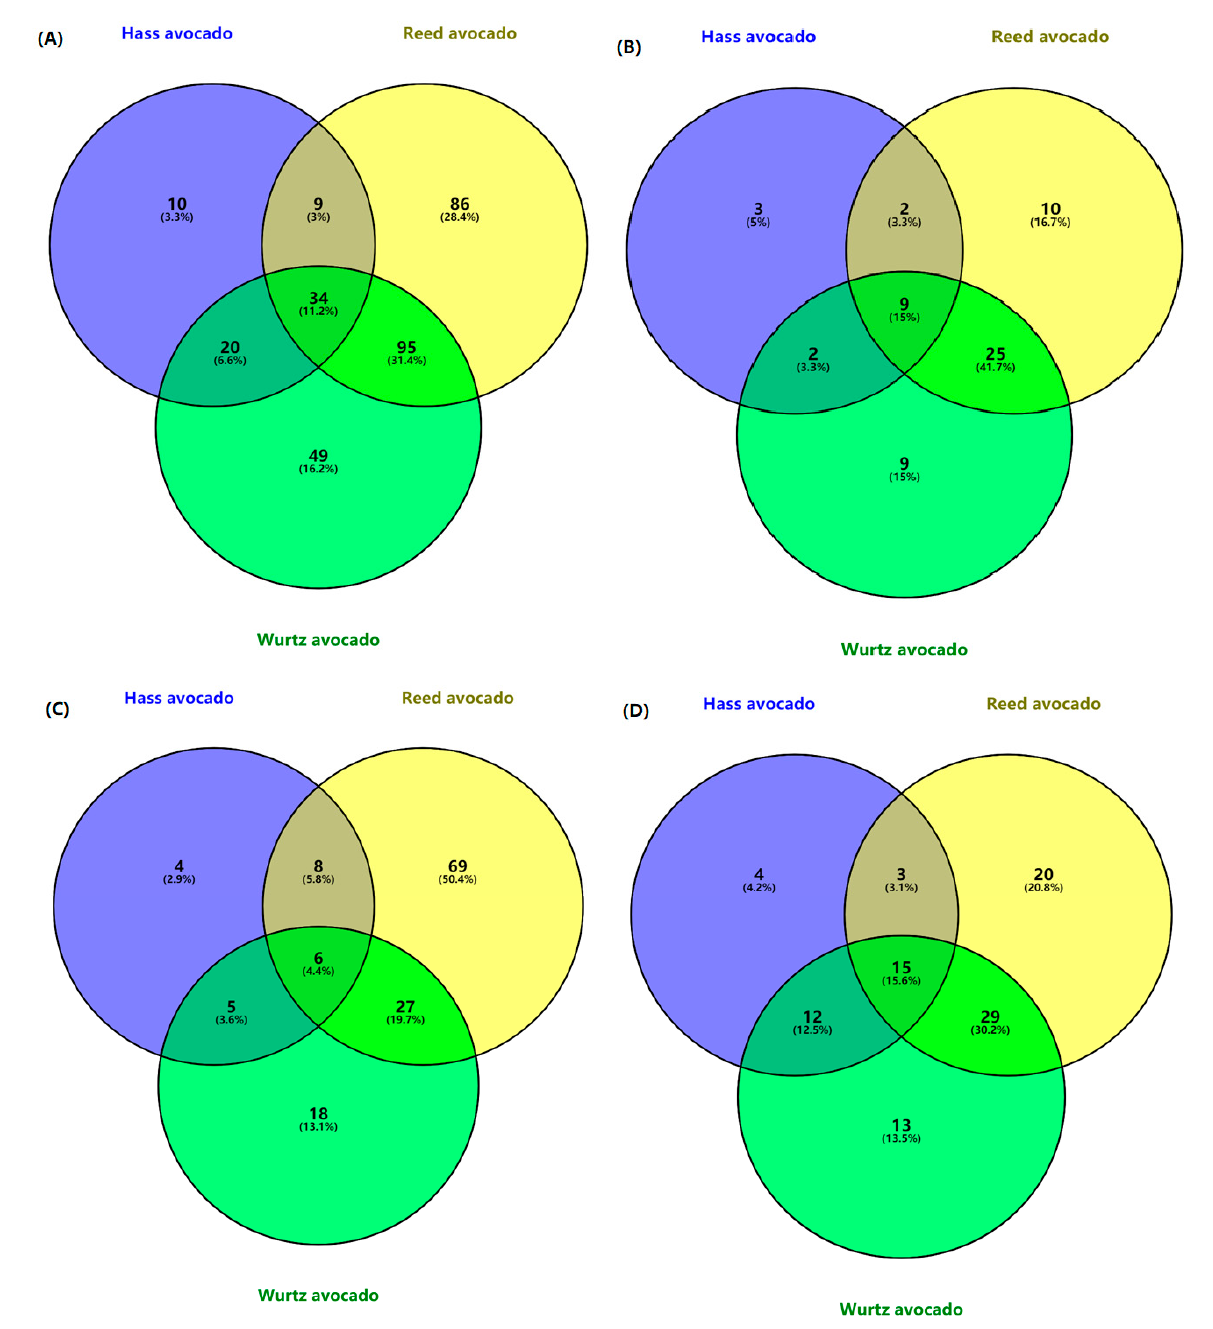
Figure 1. Venn diagrams of phenolic compounds in various rejected avocado samples. ( A ) The relations of total phenolic compounds in different avocados; ( B ) the relations of phenolic acids in different samples; ( C ) the relations of flavonoids in different avocados; ( D ) the relations of other phenolic compounds in rejected